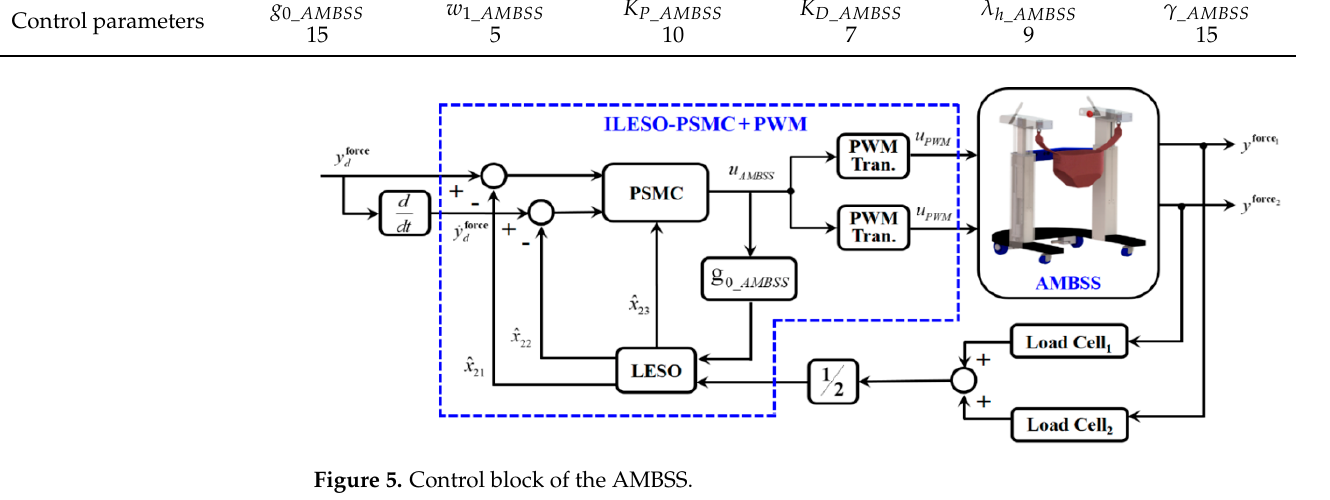
Table 1. Parameters of the ILESO-PSMC with PWM for the AMBSS experiment. Control parameters